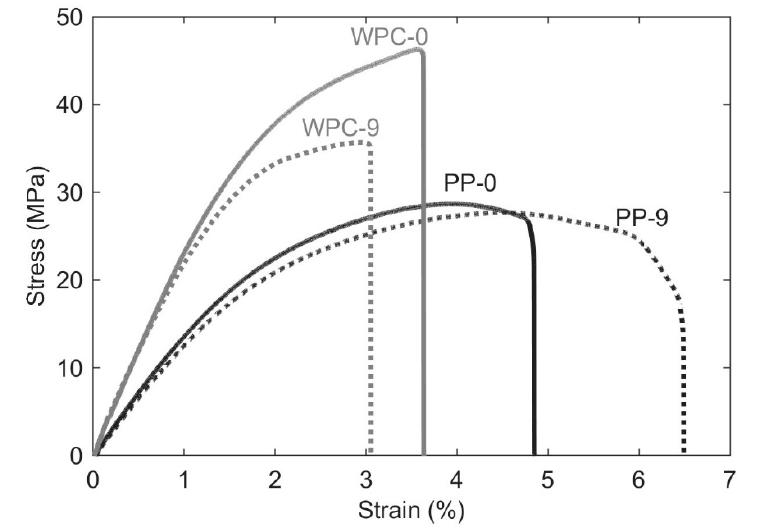
Figure 9. Stress-strain curves for PP-0, PP-9, WPC-0, and WPC-9 under tensile tests.